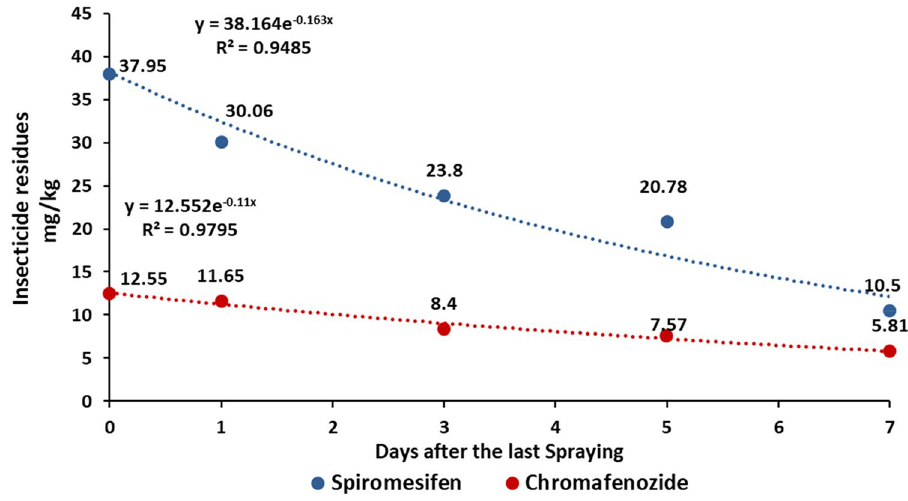
Figure 2. Dissipation patterns and half-lives of insecticides in perilla